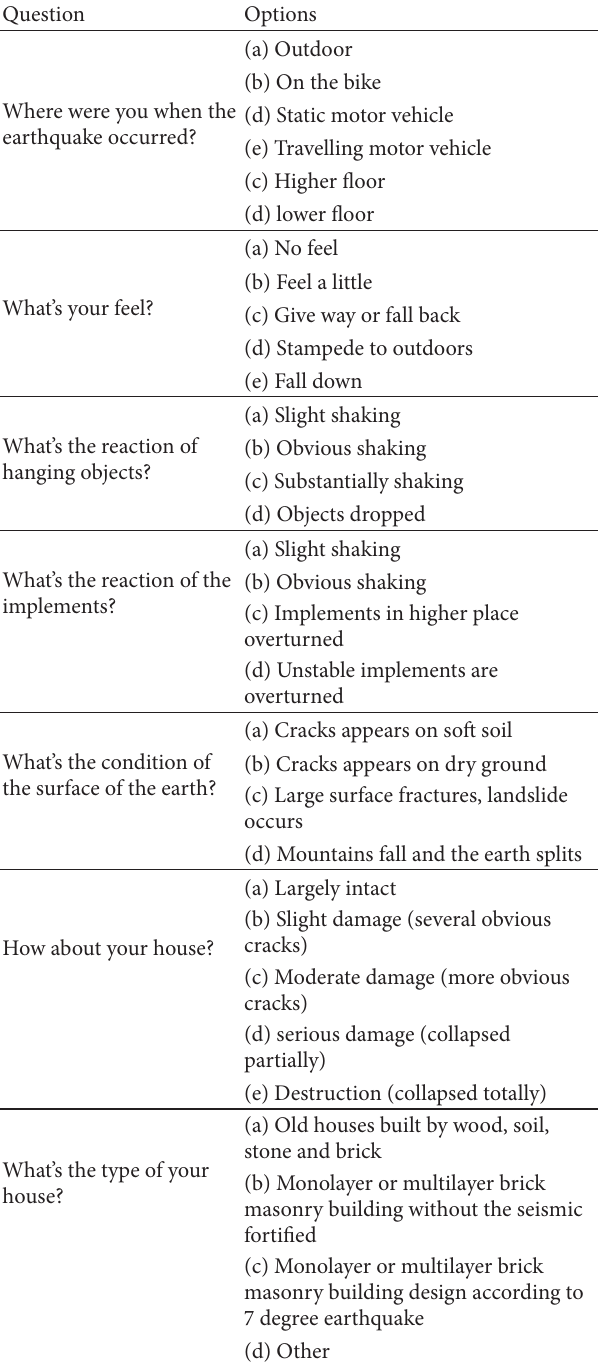
Table 4: All questions and options on questionnaire. Question